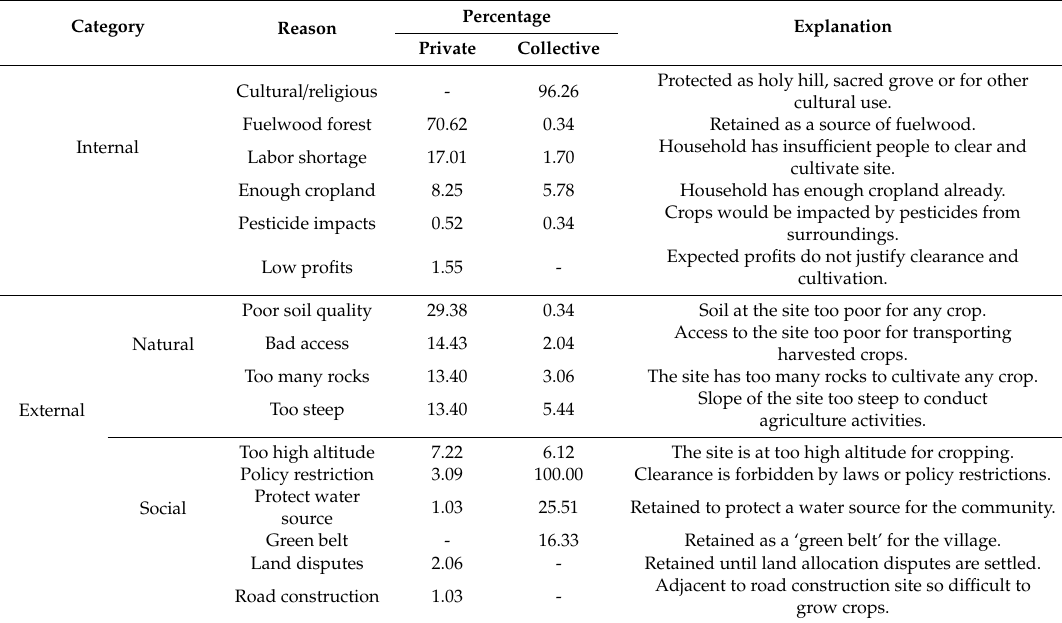
Table 1. Reasons for the retention of natural forest fragments. Percentages are the percentage of interviewees who gave this